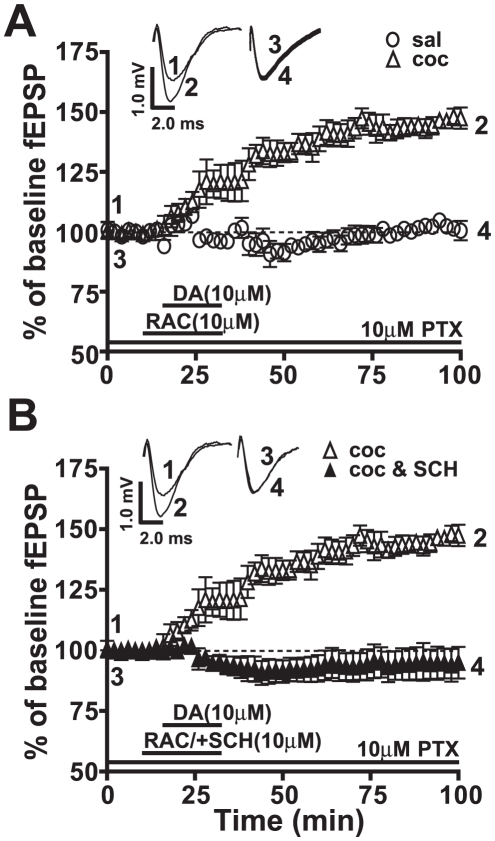
The endogenous neurotransmitter, dopamine (DA), in the presence of raclopride (RAC), a D2R antagonist, induced LTP mediated through D1/5R activation.Responses are plotted as percent change of baseline fEPSPs as a function of time. Numbers on the representative traces show the time on the graph at which they were recorded. A) DA in the presence of RAC (clear triangles, 146.5±3.2%, *p<0.05, n = 5) shows potentiation similar to that recorded with SKF81297 (Figure 1B) in amygdala slices from cocaine CPP animals while the saline-treated group (clear circles, 102.2±2.4%, ns, n = 5) exhibits no LTP. B) DA+RAC-induced LTP is abolished by SCH23390 in the cocaine CPP group (filled triangles, 94.5±4.5%, ns, n = 6). For comparison panels A and B use same data graphs and fEPSP traces for the slices from cocaine CPP group superfused with SKF81297.